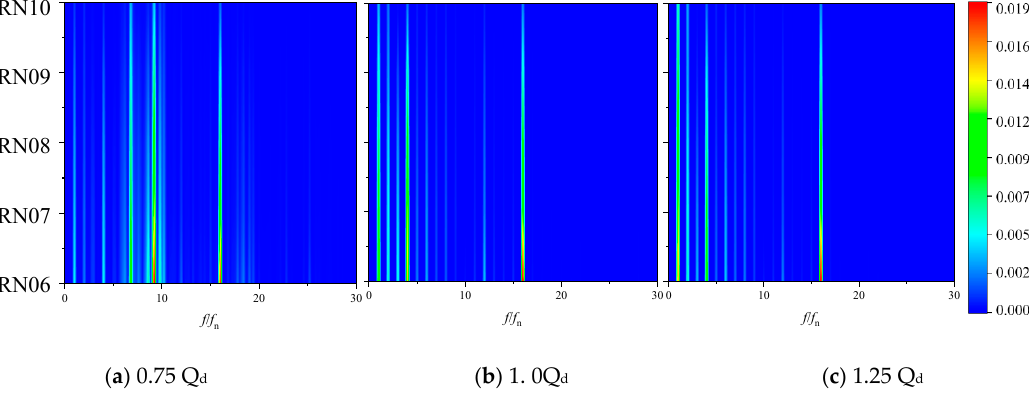
Figure 12. Frequency domain of pressure fluctuation near the suction side of the short blade.